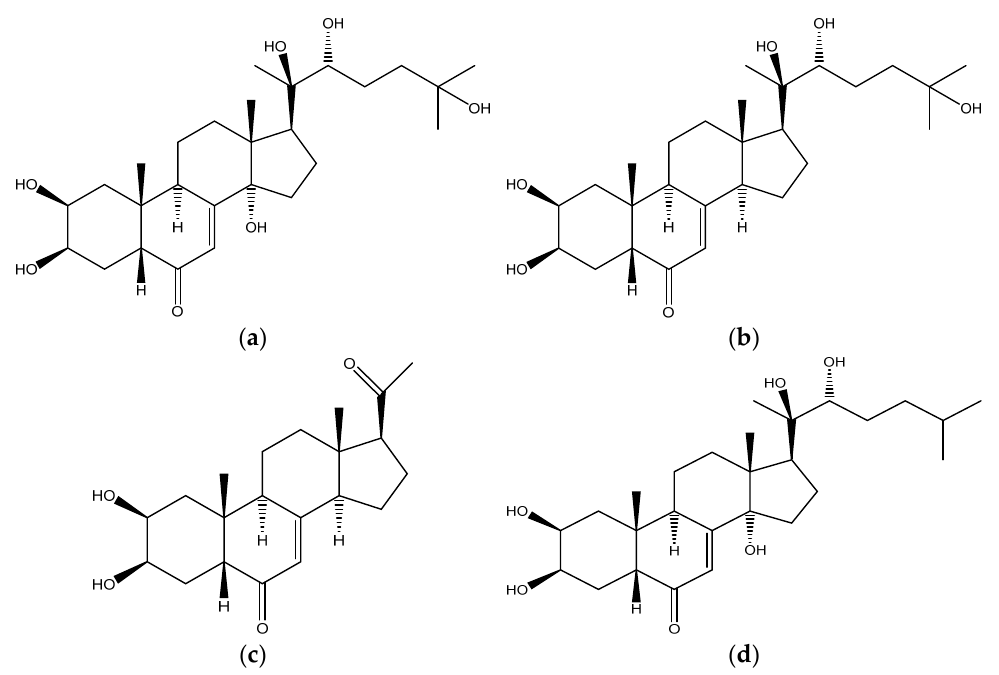
Figure 1. Chemical structure of ( a ) ecdysterone, of ( b ) 14-deoxy-ecdysterone, ( c ) 14-deoxy-poststerone, and ( d ) ponasterone (ISTD).